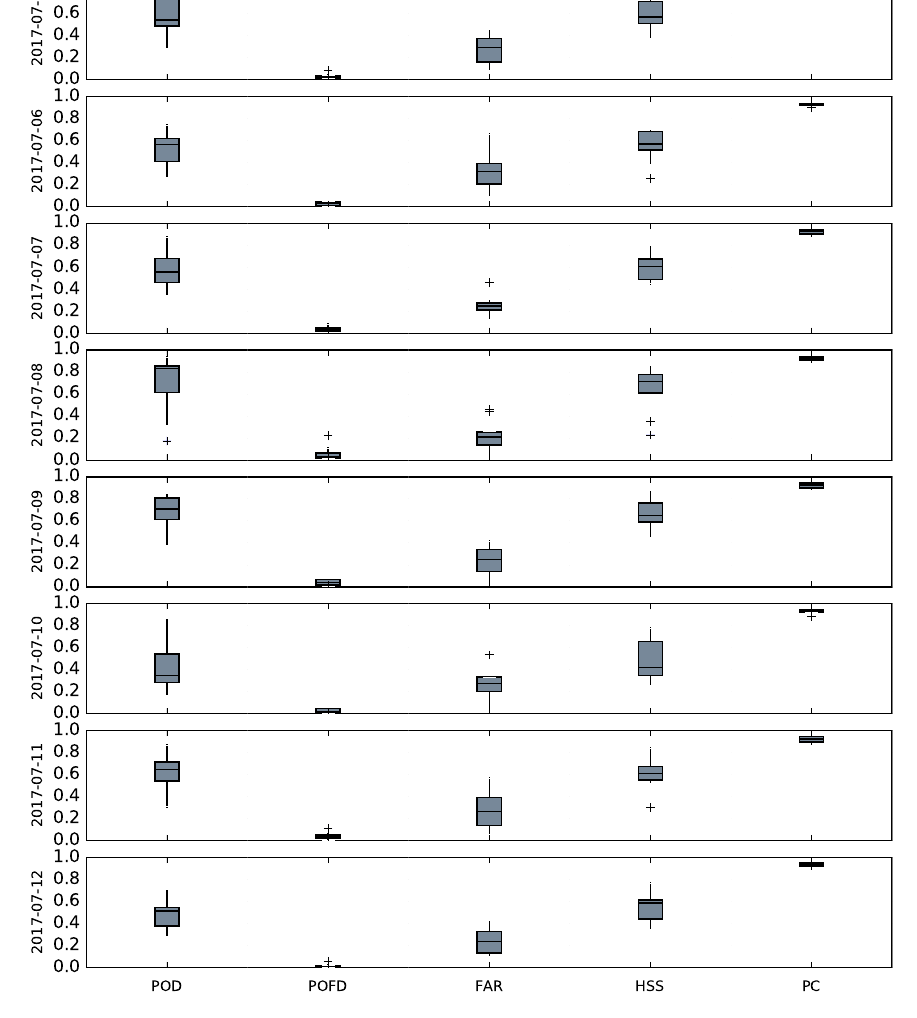
Figure 6. Performance of the precipitation area delineation for eight days (5–12 July 2017) as boxplots. The validation scores are calculated for each validation scene of these eight days. The boxes display the 25th, 50th and 75th percentiles. Whiskers indicate extreme data up to 1.5 times of the interquartile range. Outliers are marked as crosses. The width of the boxes is relative to the available number of validation